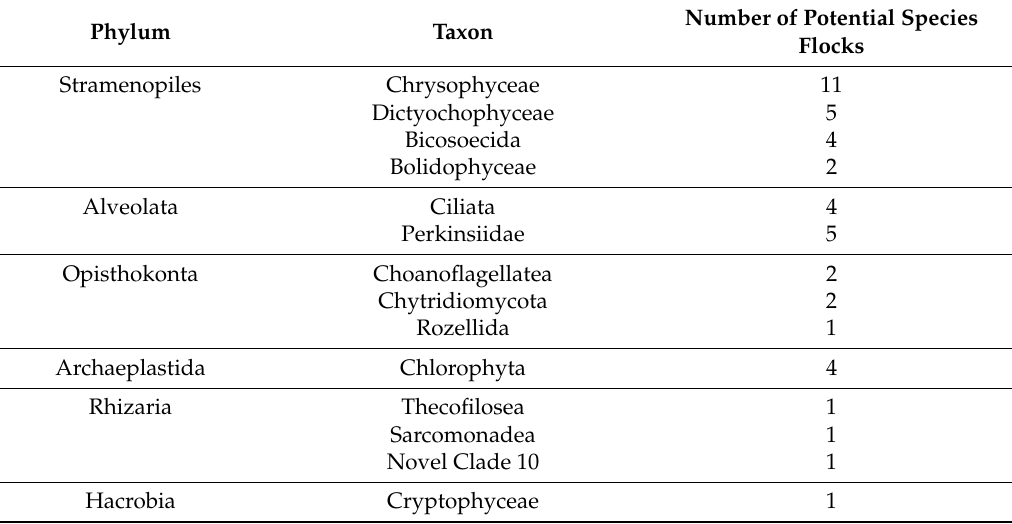
Table 1. Potential species flocks in Lake